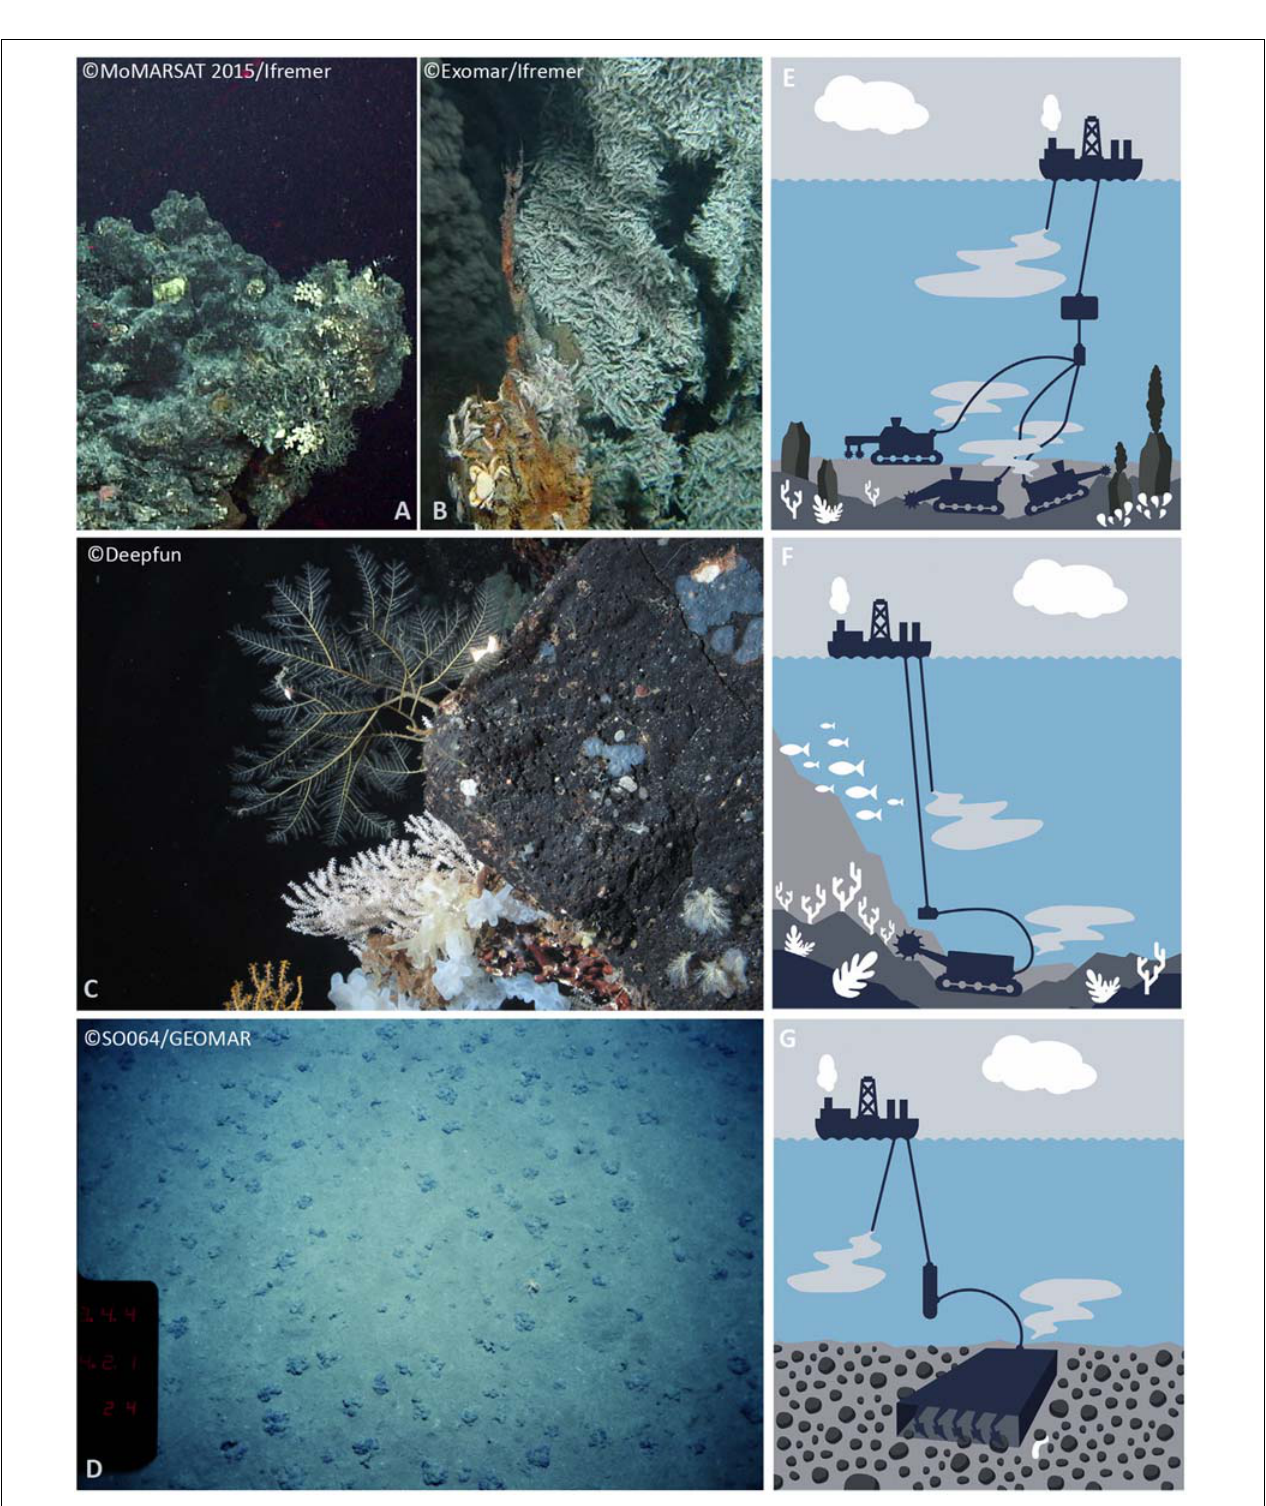
FIGURE 1 | Overview of the ecosystem of interest to mining and examples of associated biological communities at inactive (A) and active hydrothermal vents (B) , seamounts (C) and nodule fields (D) . Next to each ecosystem, mining scenarios are portrayed for polymetallic sulphides at vents (E) , cobalt-rich ferromanganese crusts at seamounts (F) , and polymetallic nodule mining at abyssal plains (G) ( E–G were taken from Gollner et al., 2017). Maps of licence areas and resource to be mined can be found at https://www.isa.org.jm/maps.